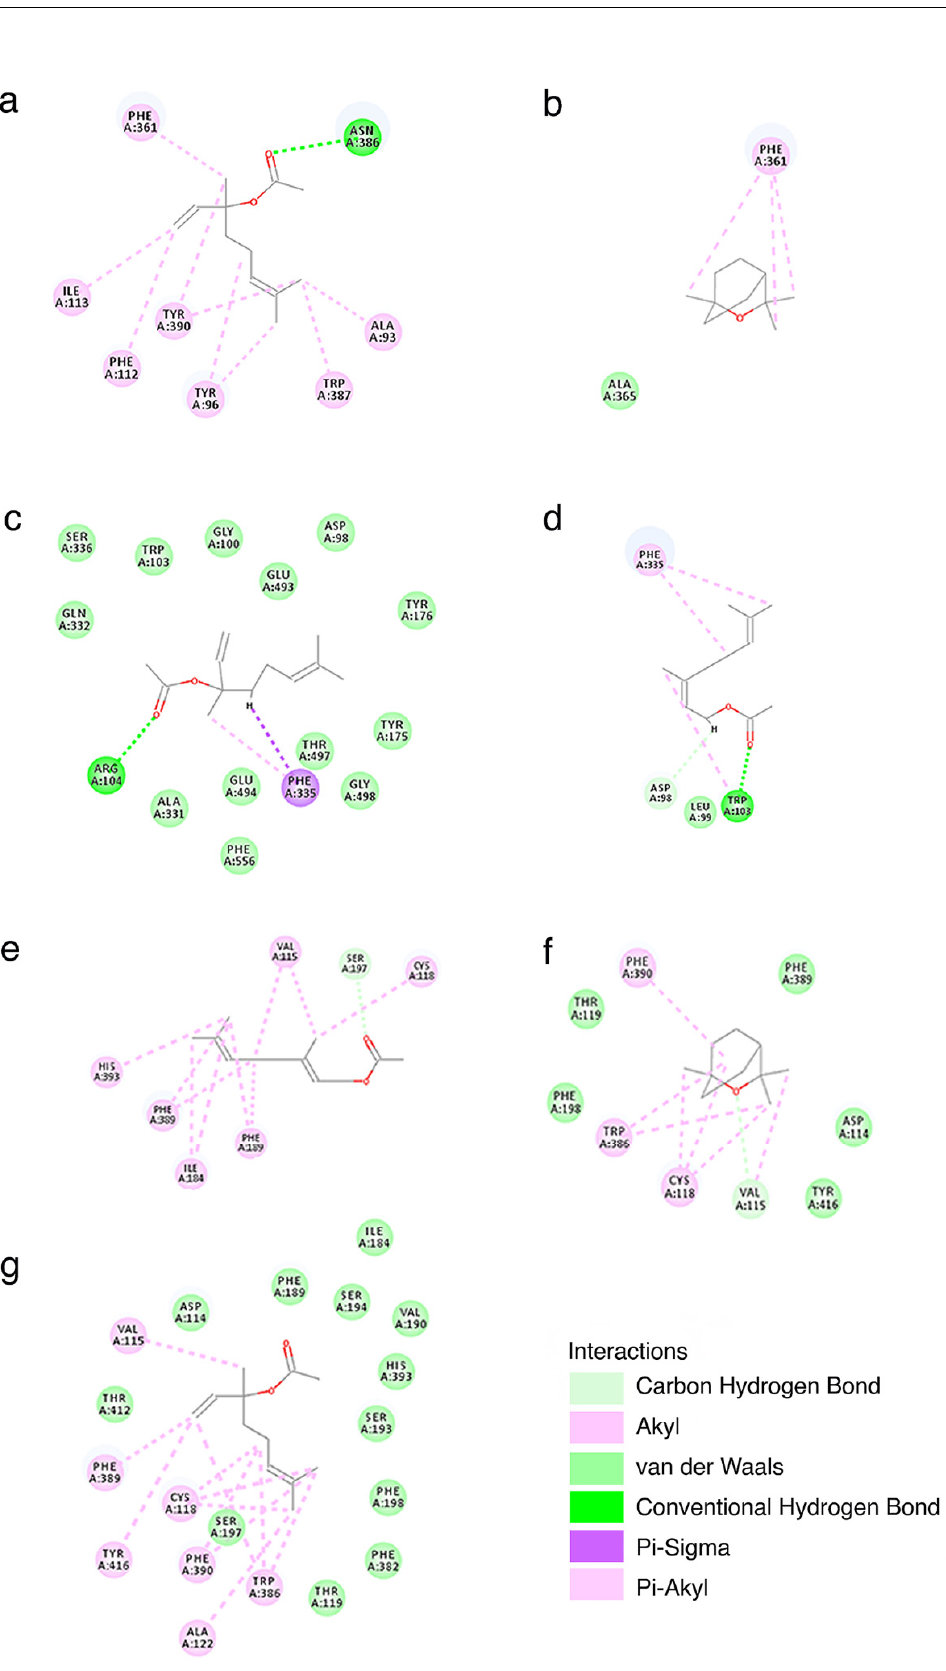
Figure 2. Interaction maps (2D) calculated based on the complexes formed by linalyl acetate with 5-HT1A ( a ), SERT ( c ), or D2 ( g ); 1,8-cineole with 5-HT1A ( b ) or D2 ( f ) and neryl acetate with SERT ( d ) or D2 ( e ). The maps were generated using Discovery Studio Visualizer v21.1.0.20298 (BIOVIA Dassault Systemes, San Diego, CA,